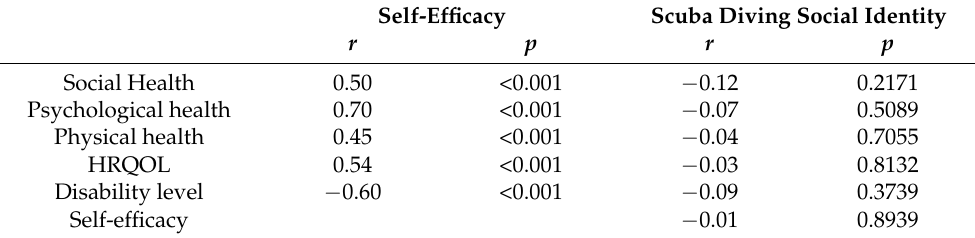
Table 5. Pearson’s correlation coefficients.